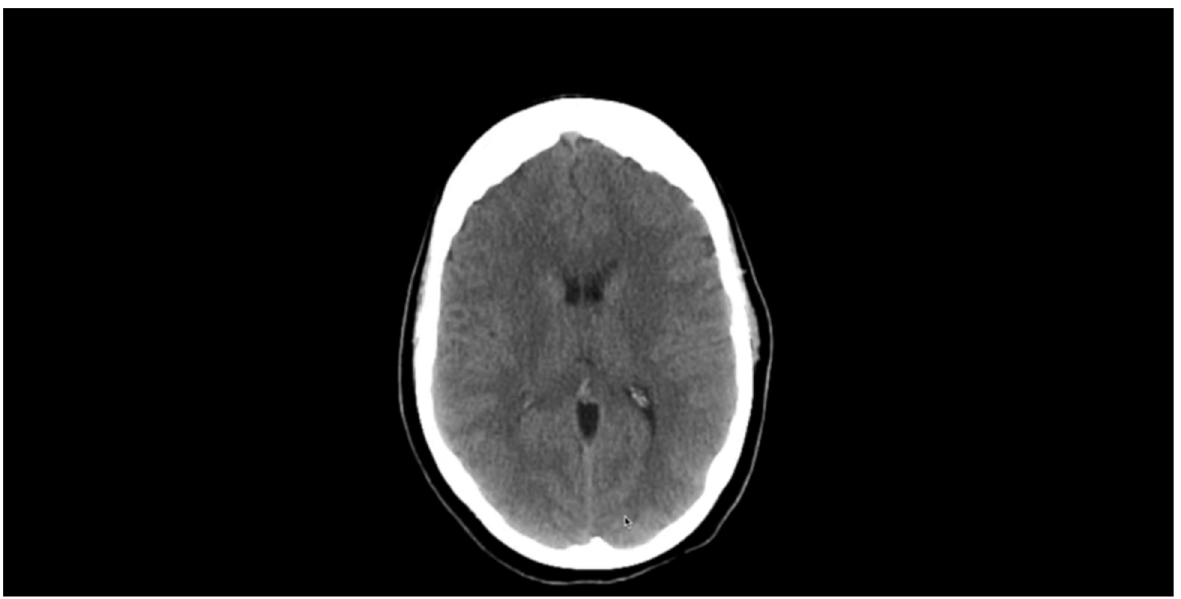
Figure 4. Brain CT showing complete resolution of scolexes following three-month albendazole